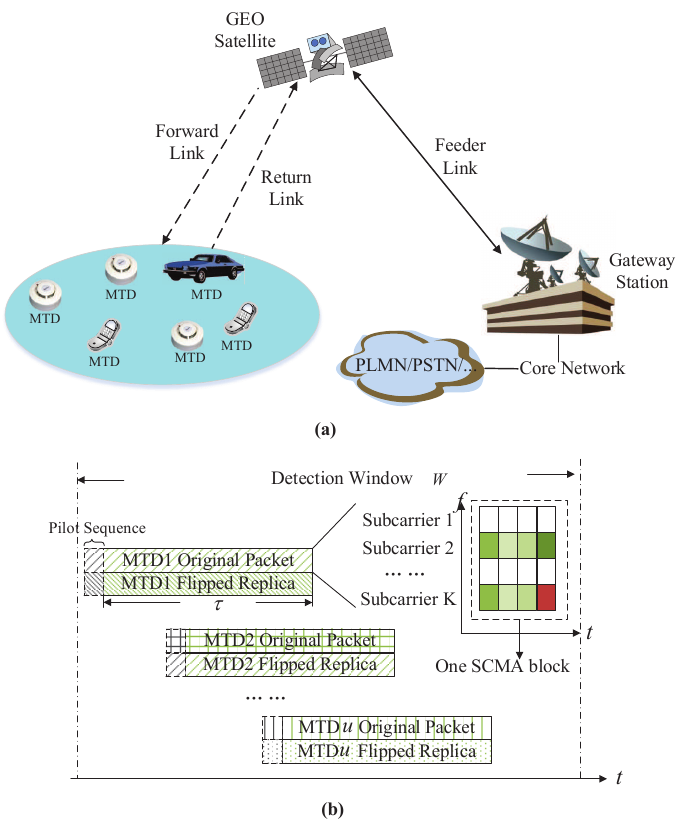
Figure 1. Asynchronous flipped SCMA for satellite communication networks. Different shadowed chunks in ( b ) represents packets encoded with different SCMA codebooks. ( a ) Satellite communication scenario under consideration; ( b ) situation of packet arrivals at the gateway